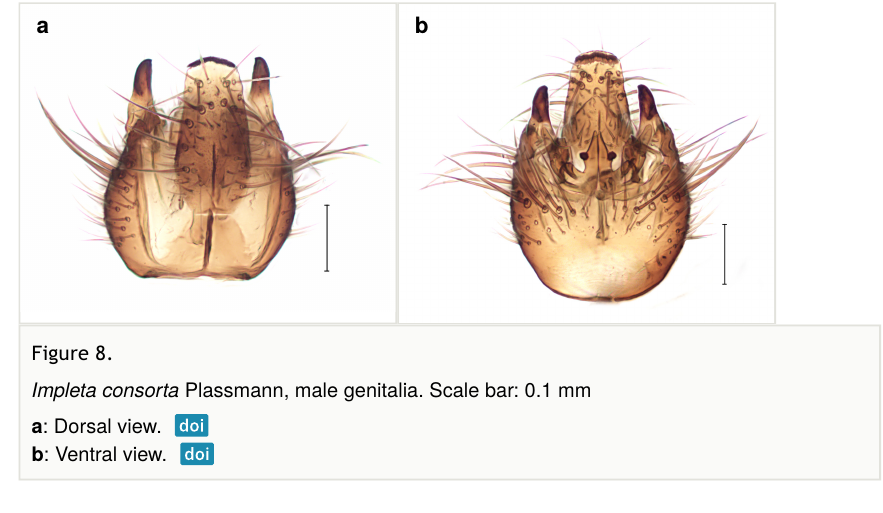
(Polevoi and Barkalov 2017). Ecology Poorly known. Some specimens were caught with light traps (Plassmann 1980, Kurina aspen, colonised by 15 species of macrofungi Table 1. Conservation